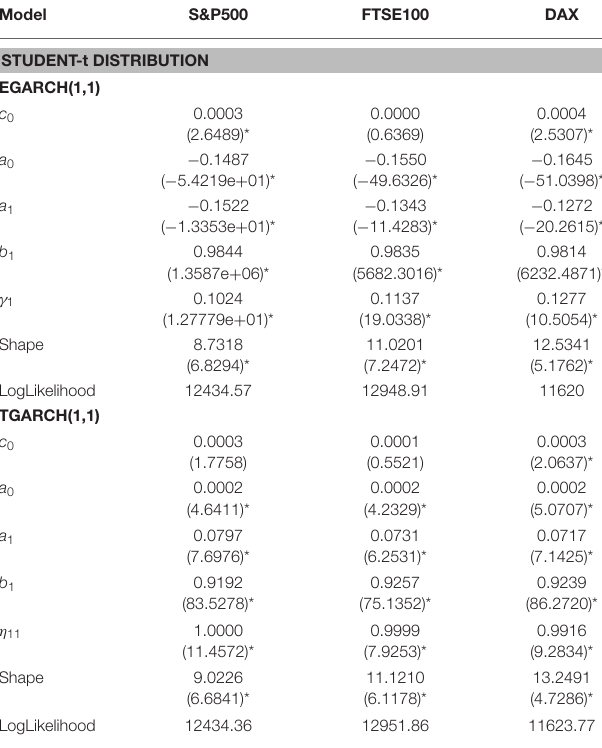
TABLE 5 | Parameter estimates of EGARCH and TGARCH models for three equity indices using the entire data set and assuming normal distribution for the residuals, t-statistics are presented in parentheses.